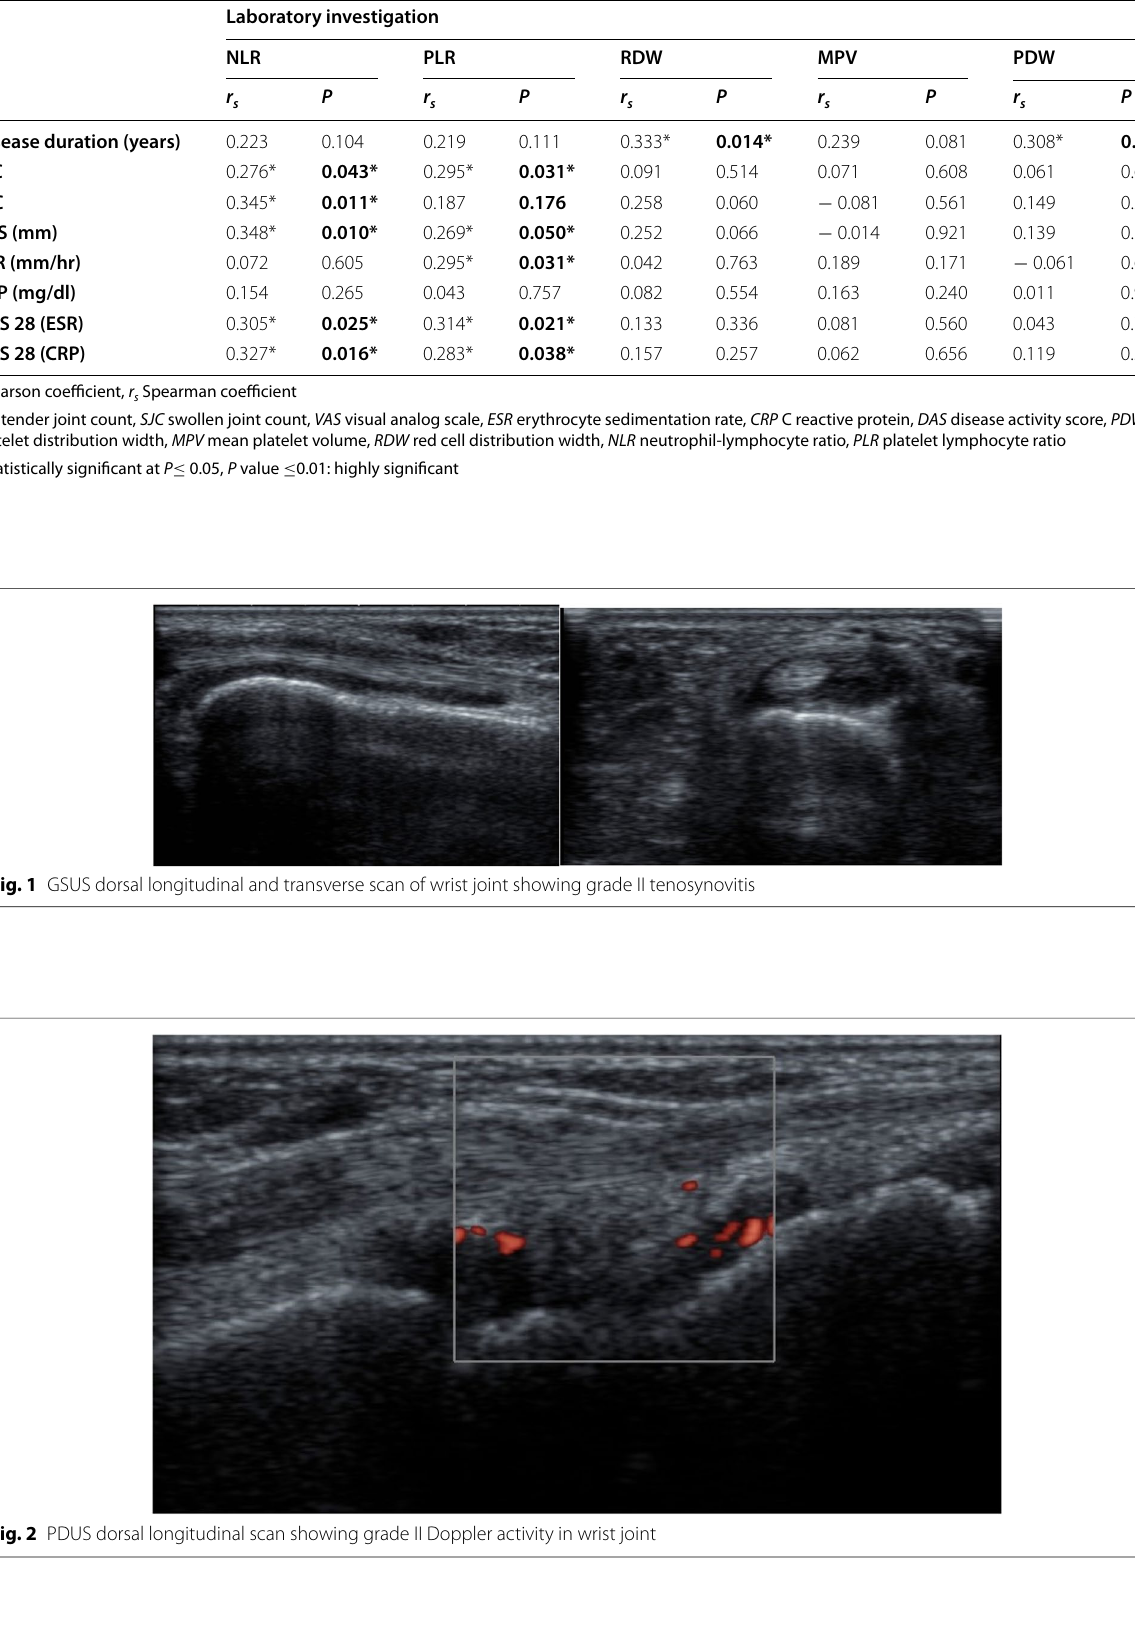
Table 4 Correlation between the hematological marker and different parameters